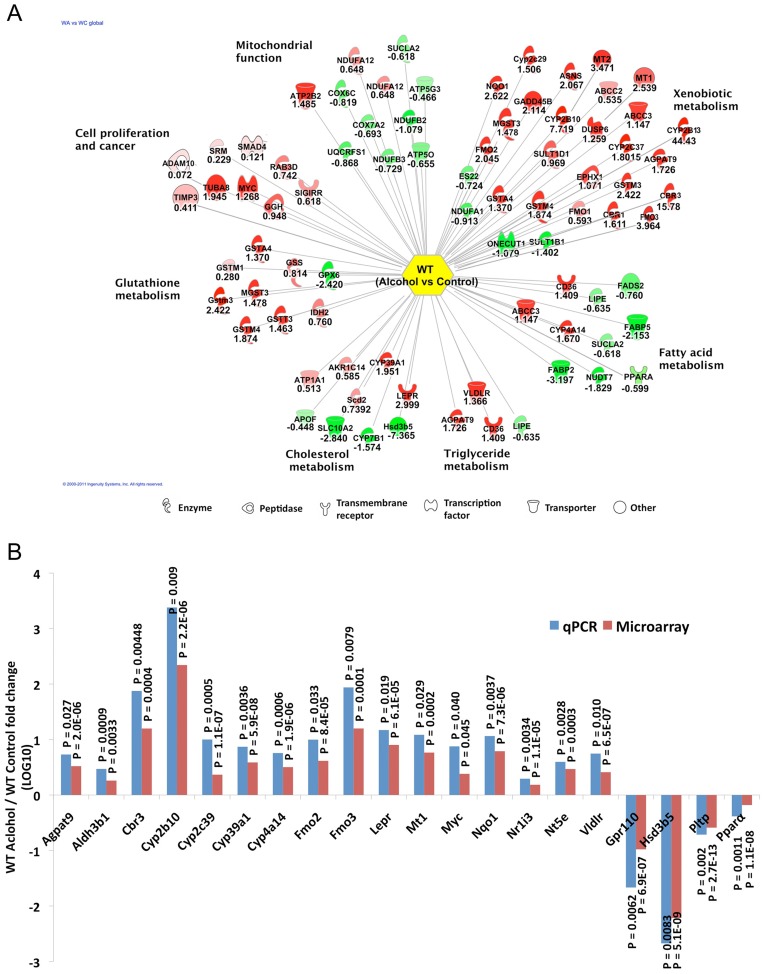
Hepatic gene expression profile is altered in the wild type mice upon feeding an alcohol-containing liquid diet for 6 weeks.
A. IPA of the microarray data demonstrated dysregulation of genes involved in different pathways in the livers of mice fed alcohol diet. The number below each gene represents the fold change in expression (log2) in livers of mice fed alcoholic diet compared to that in controls. The shapes represent the functional class of each gene. B. qRT-PCR analysis validated microarray data of selected genes dysregulated in the wild type mice fed alcoholic diet compared to the controls. Fold changes in log10 scale are presented. qRT-PCR was performed with gene-specific primers using SYBR Green chemistry. Each sample was analyzed in quadruplicate.